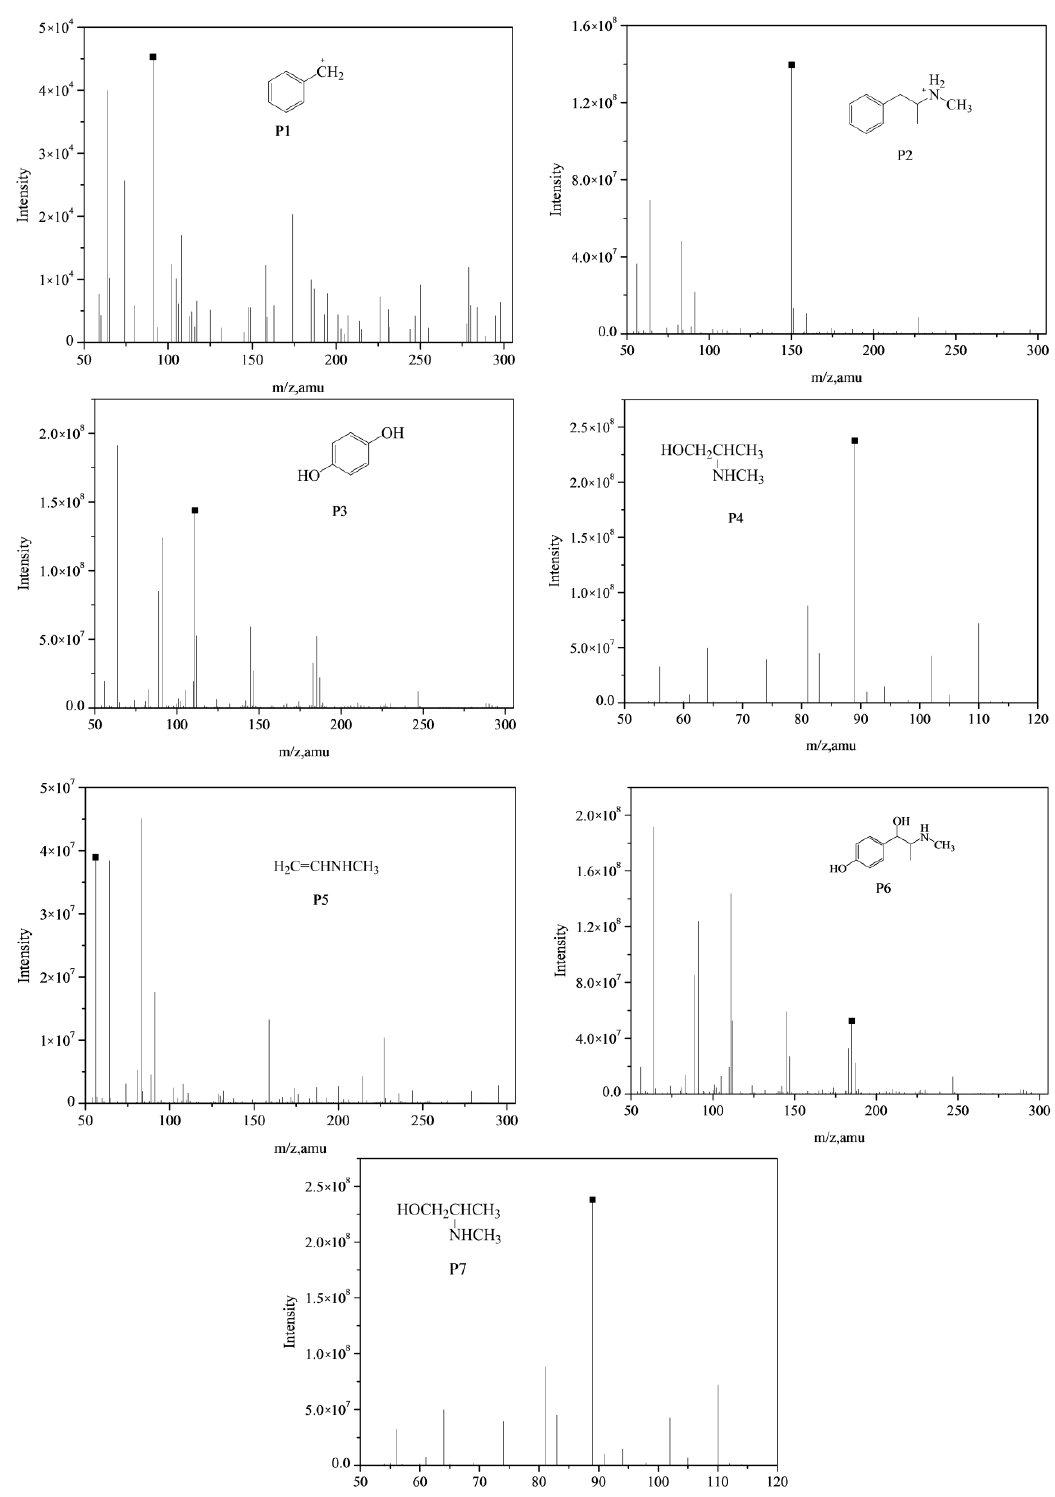
Figure 12. Mass spectra of the intermediate products of METH in the UV/PS system.